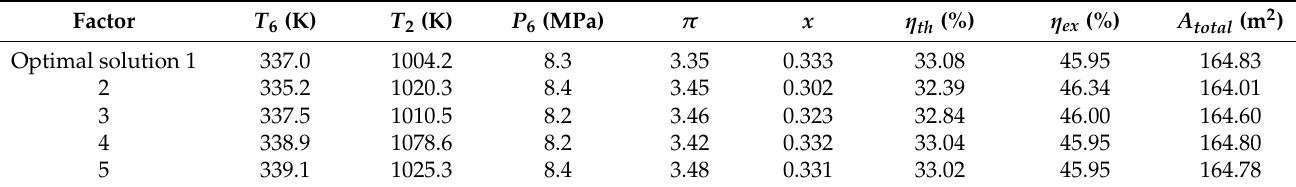
Figure 13. Three objectives Pareto optimal solution for η th , η ex , and A total . Table 8. Pareto optimal solution for η th , η ex , and A total .